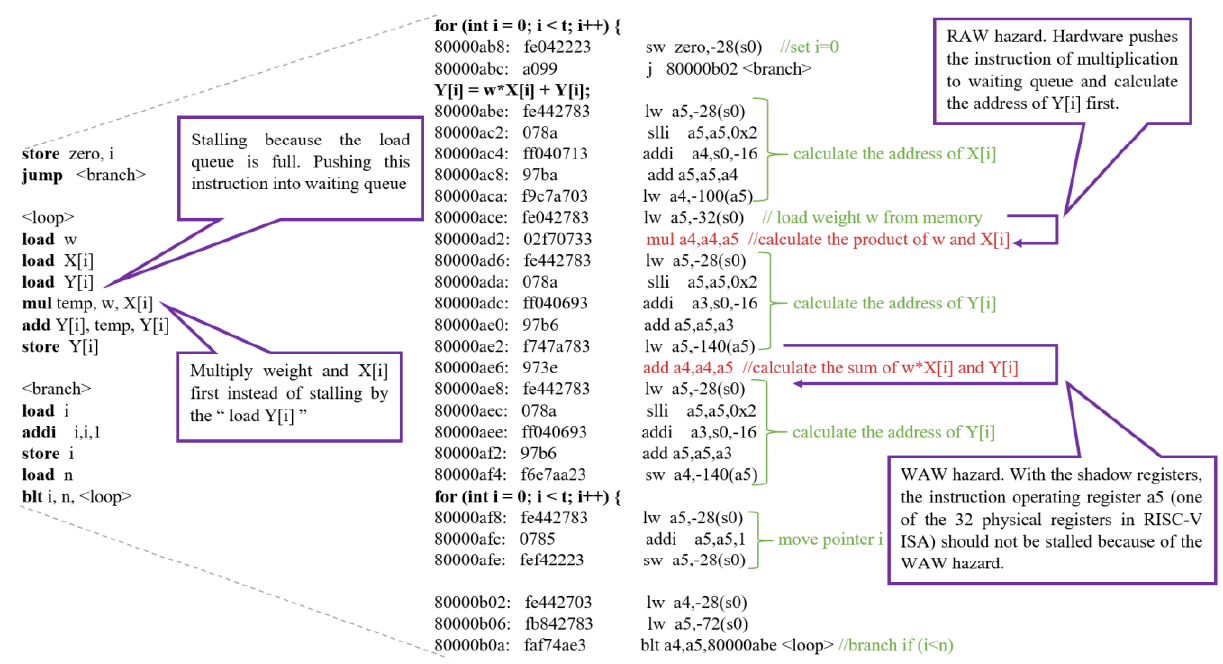
Figure 10. Assembly codes of SAXPY computation. Left, the handwritten assembly codes. Right, the assembly codes compiled by GCC compiler with optimized level of − O3 (the most).